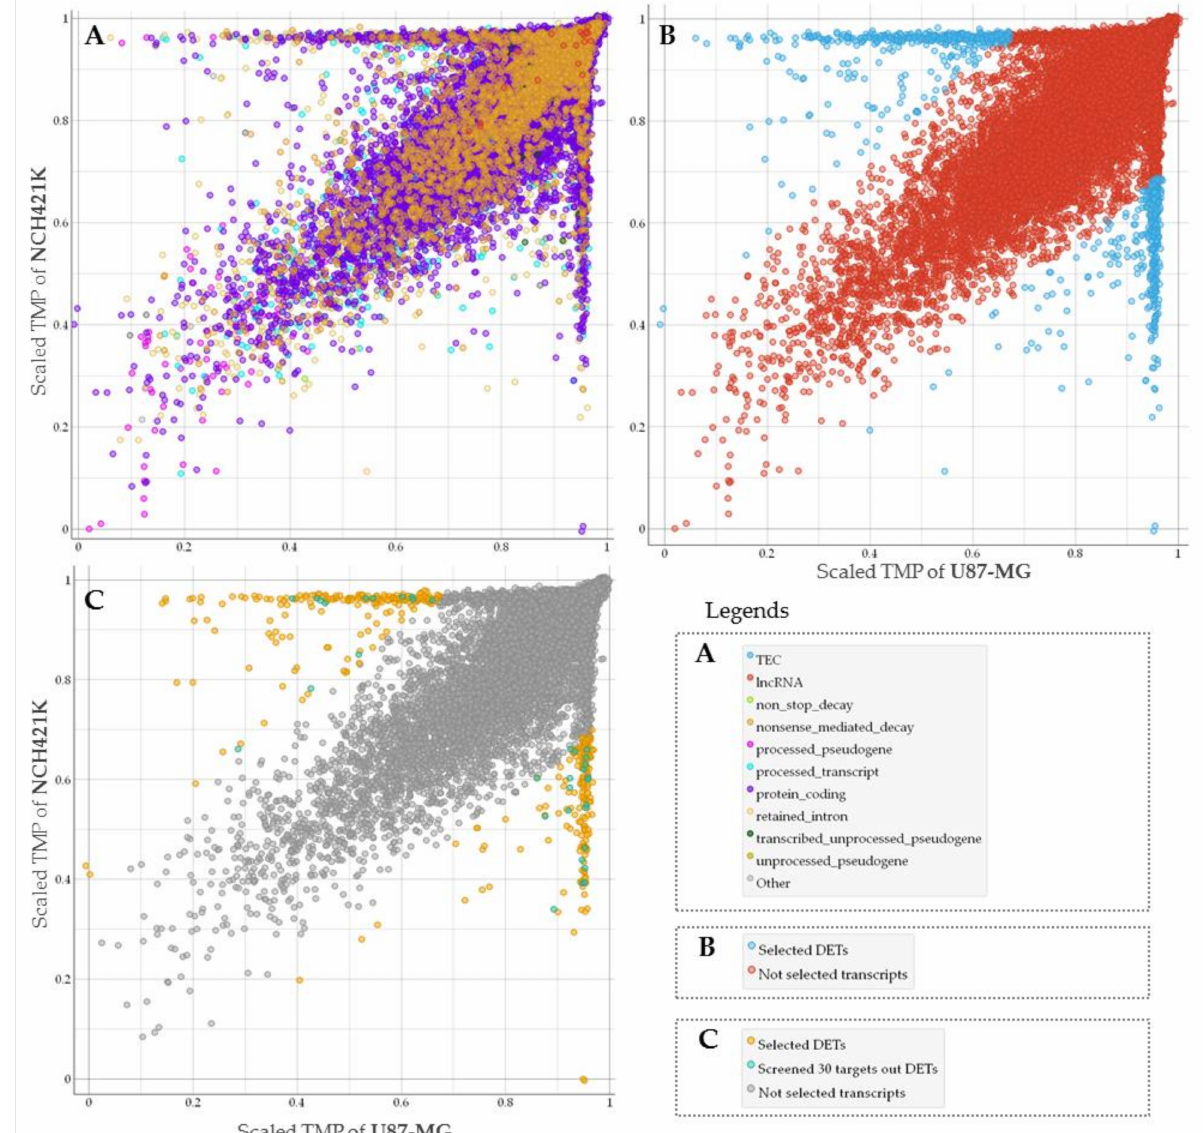
Figure 1. ( A ) The general view of all types of sequenced transcripts plotted based on NCH421K and U87-MG level (TMP— transcripts per million) distribution. TPM values scaled to interval from 0 to 1. ( B ) Screened molecules (represented in blue dots) according to differentially expressed transcripts (DETs) analysis. ( C ) Only protein-coding transcripts showed. Transcripts represented in turquoise dots were chosen for classifier based on feature selection model, yellow dots represent selected differentially expressed protein coding